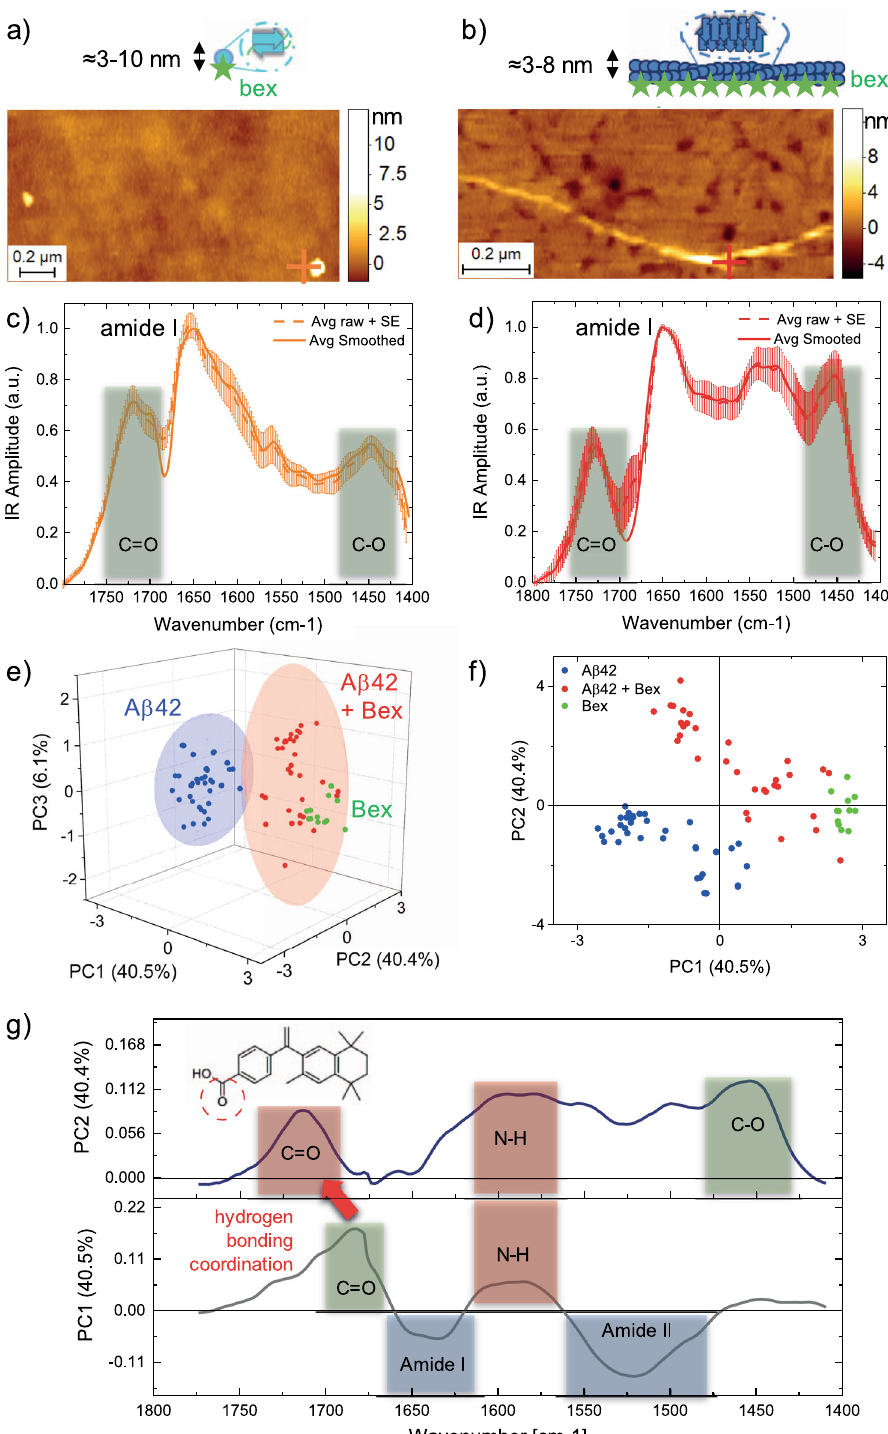
Fig. 3 Structural characterisation of the interaction of bexarotene with single A β 42 oligomers and fi brils. AFM-IR morphology maps a oligomeric (light blue sphere) and b fi brillar species (dark blue rod). The morphology of the aggregates was reproducible and consistent on at least fi ve independent and randomly chosen areas on the surface. Nanoscale localised IR absorption spectra ( c , d ) of oligomeric ( a , c ) and fi brillar species ( b , d ) of A β 42 incubated with bexarotene (Bex). We represent two spectra: (i) the average + SE of the raw spectra and (ii) the average + SE of the preprocessed spectra by applying an adjacent averaging fi lter (5 pts) and a Savitzky – Golay fi lter (second order, 15 pts). At least fi ve different raw spectra at each position (coloured crosses) were acquired. e , f 3-D and 2-D score plots of PCA analysis applied to A β 42 aggregates (oligomers and fi brils, n = 40) in the absence of bexarotene (blue), A β 42 aggregates in the presence of bexarotene (oligomers and fi brils, n = 31, red) and bexarotene alone ( n = 9, green). The coloured ellipsoids represent the 90% con fi dence of the variance of each group, thus demonstrating the separation of the spectroscopic signature of the aggregates in presence and absence of bexarotene. g Loading plots of the PC1 and PC2.